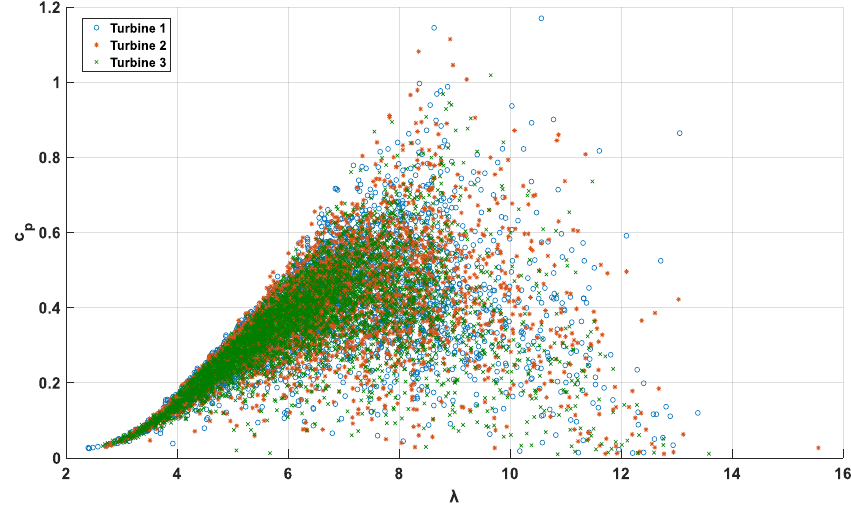
Figure 4. Raw experimental data obtained from the wind turbines.